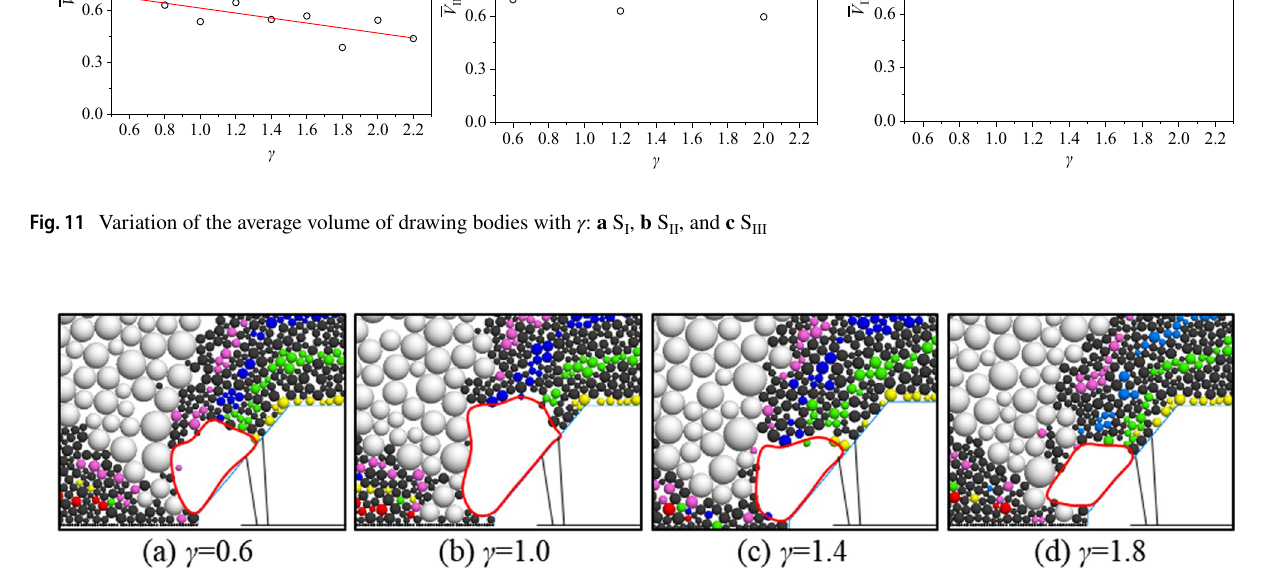
Fig. 12 Shape of DB4 for different γ